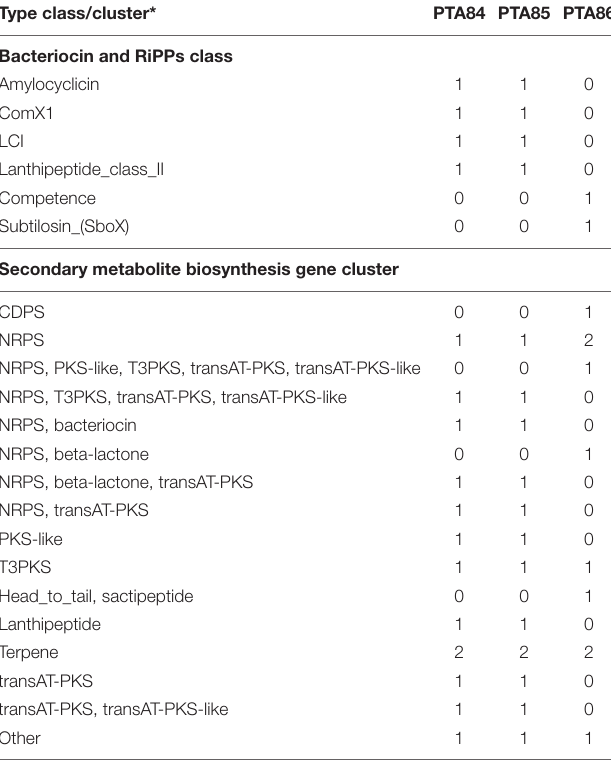
Table 11 . A thioredoxin system and genes for